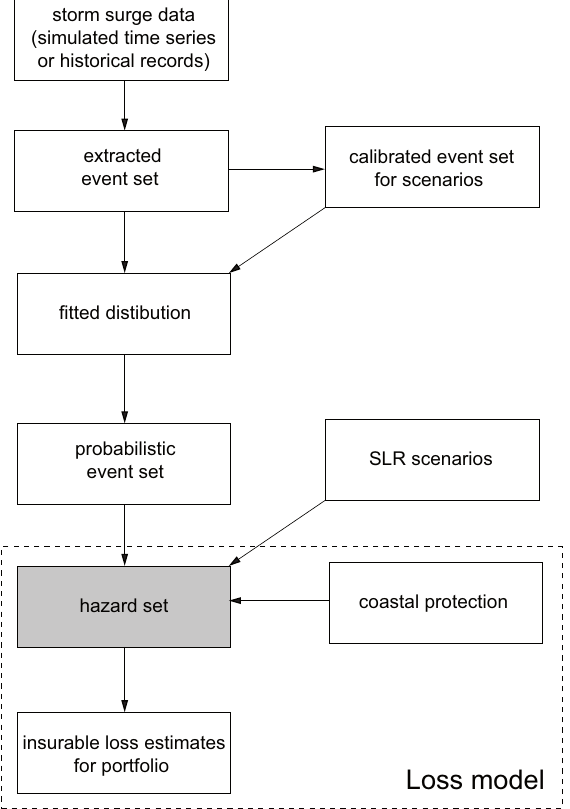
Fig. 2. Flowchart of the construction of the hazard set.